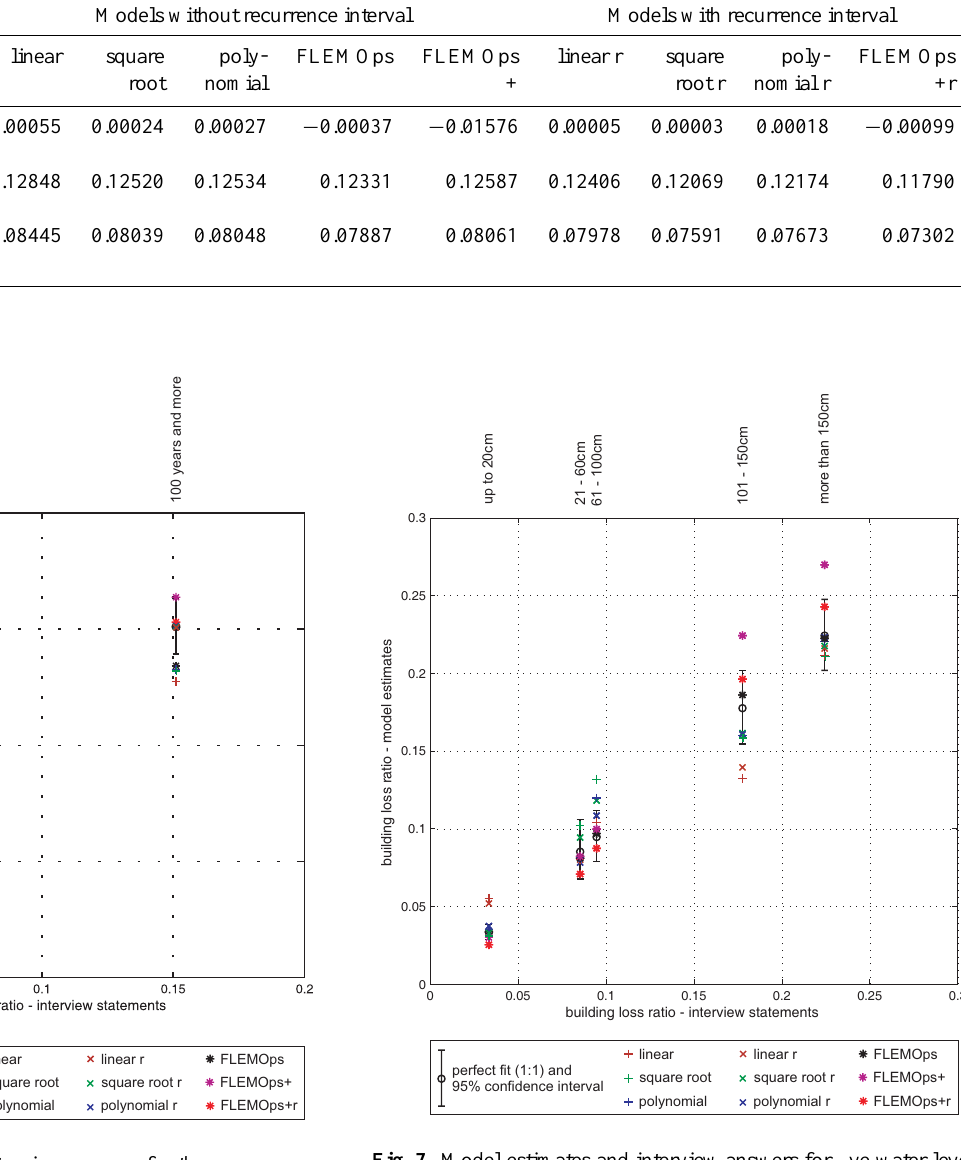
Fig. 6. Model estimates and interview answers for three recurrence interval classes.